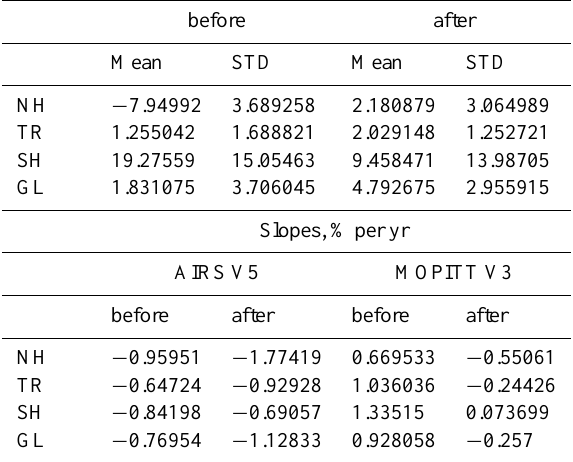
Table 4. Bias (AIRS.V5-MOPITT.V3) and STD of monthly mean burdens for Northern hemisphere, tropics, Southern hemisphere, and globally (70 ◦ S –70 ◦ N) in % for the common period of mea-